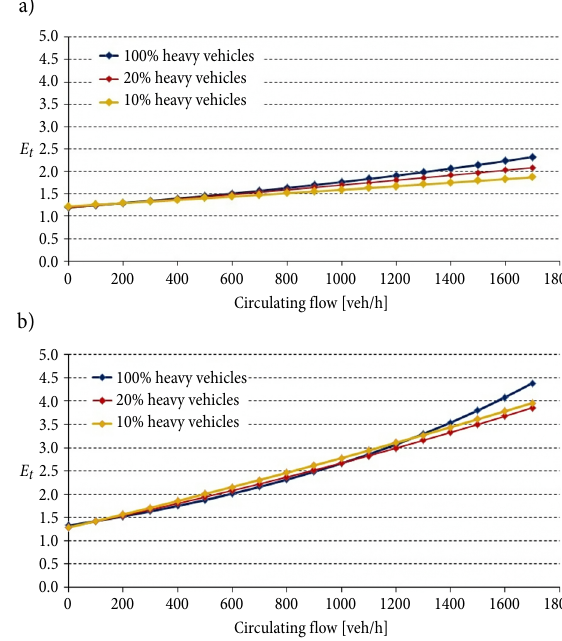
Fig. 6. PCE estimations: a – left-lane on major entries; b – right-lane on minor entries